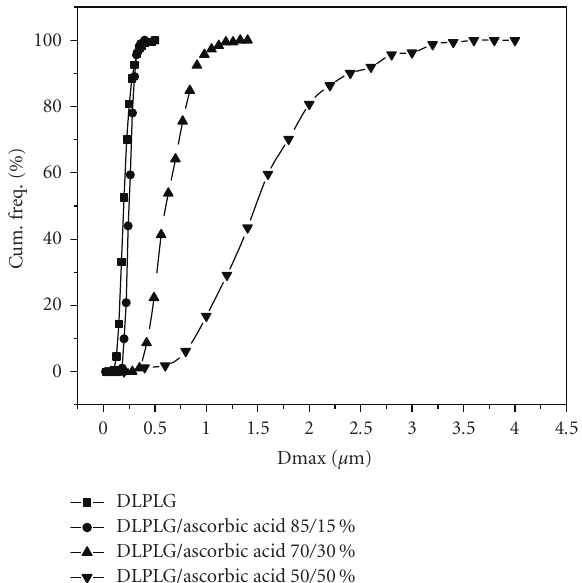
Figure 7: Comparative results of the stereological examining of DLPLG particles and particles with di ff erent ratio of DLPLG and ascorbic acid, DLPLG/ascorbic acid 85/15%, DLPLG/ascorbic acid 70/30%, DLPLG/ascorbic acid 50/50%, based on area section Aa.